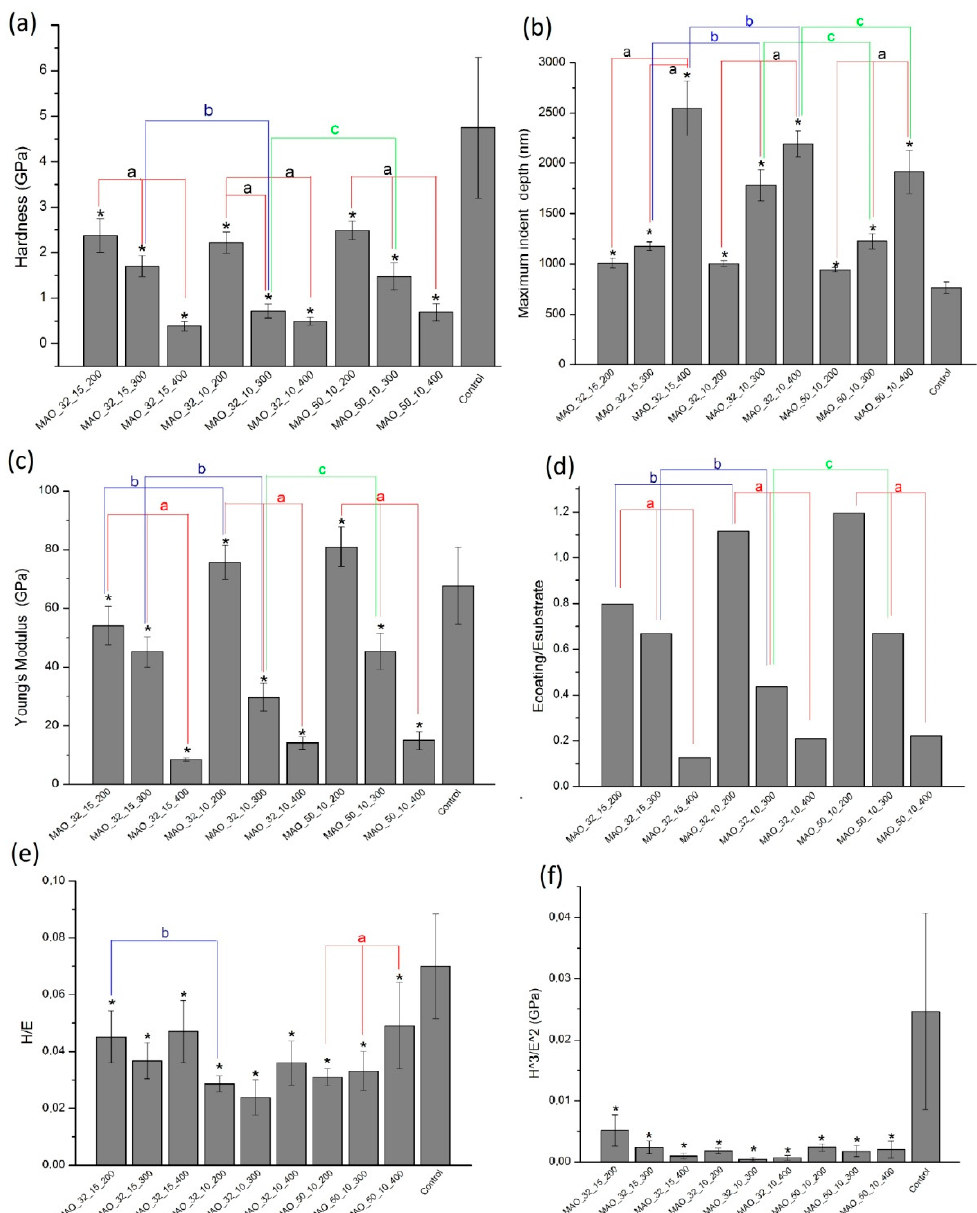
Figure 8. Nanomechanical properties: Nanohardness ( a ), maximum indent depth ( b ), Young’s modulus ( c ), E coating / E substrate ratio ( d ), H / E ratio ( e ), H 3 / E 2 ratio ( f ), of investigated MAO coatings with various MAO process parameters and control specimens (n = 10; * significantly di ff erent from control ( p < 0.05), (a) significantly di ff erent in groups ( p < 0.05), (b) significantly di ff erent between time groups ( p < 0.05), (c) significantly di ff erent between current groups ( p < 0.05)).